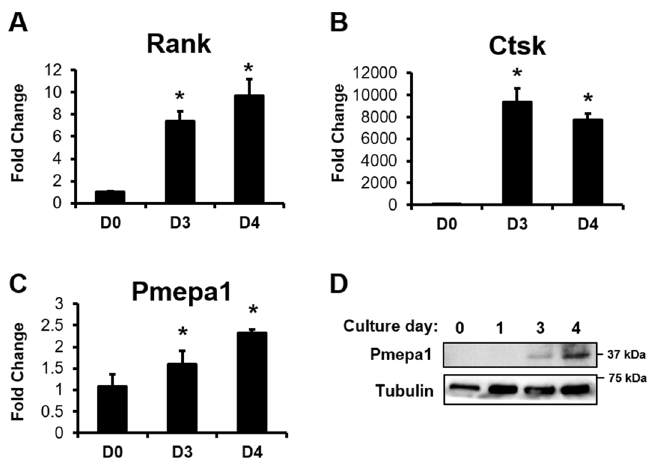
Figure 6. Pmepa1 expression increases during the fusion stage of osteoclastogenesis. Bone marrow macrophages were collected from WT 6-week-old male or female mice and cultured in the presence of RANKL and M-CSF for the indicated days. Shown are cultures from female mice. Expression levels of ( A ) Rank, ( B ) Ctsk and ( C ) Pmepa1 were evaluated by qPCR. * p < 0.05 ( D ) Western blotting was